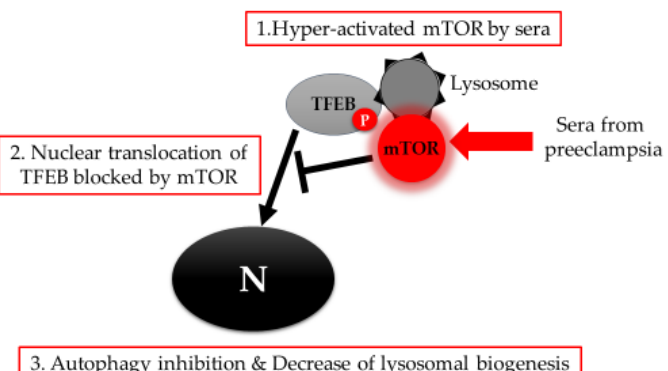
Figure 1. TFEB-mediated autophagy inhibition. Sera from preeclampsia induce hyper-activation of mTOR, which blocks nuclear translocation of TFEB. TFEB inactivation results in the inhibition of autophagy and lysosomal biogenesis in trophoblasts. N: nucleus.